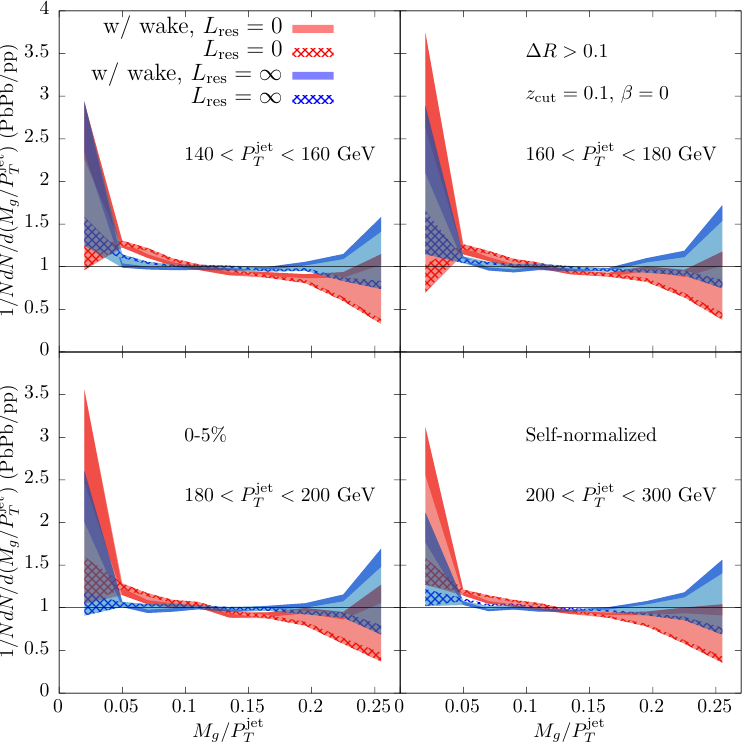
Figure 13 . Ratios of the individually self-normalized distributions of M g =p jet to those in pp collisions, for di(cid:11)erent ranges of the ungroomed jet momentum p jet grooming procedure, with Soft Drop parameters z cut = 0 : 1 ; (cid:12) = 0. Red (blue) curves correspond to model calculations with a medium that has L res = 0 ( L res = 1 ). Solid curves correspond to the full results which include particles coming from the wake in the medium; in dashed curves we show results which don’t include